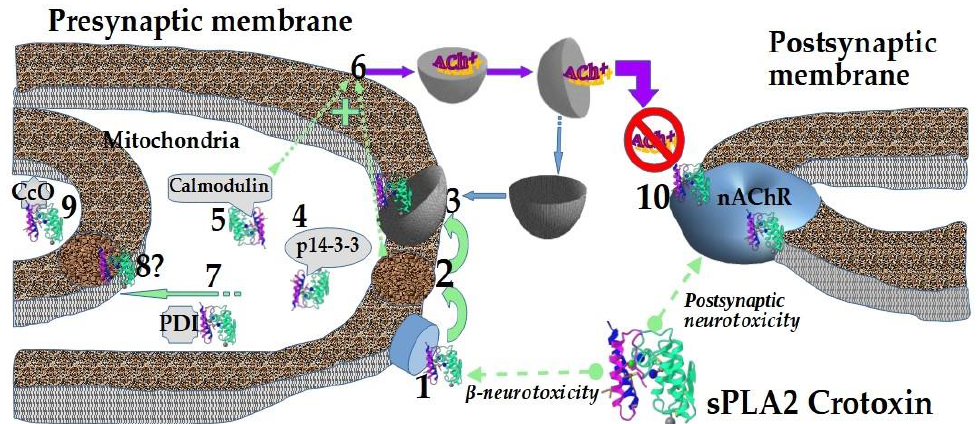
Figure 1. The main processes within neuro-muscular junction known to be affected by snake venom sPLA2 crotoxin: 1—binding to a specific site at presynaptic membrane (presumably to N-type sPLA2 receptor); 2—a general membrane-destabilizing effect and phospholipolysis; 3—translocation across the membrane using the synaptic vesicle recycling machinery; 4—binding to proteins 14-3-3 for localization inside the nerve ending; 5—stabilization by calmodulin with increasing the enzymatic activity; 6—enhancement of exocytosis of acetylcholine (Ach) by products of phospholipolysis; 7—retrograde trafficking provided by protein disulfide isomerase (PDI); 8—putative crossing the outer mitochondrial membrane; 9—binding to subunit II of mitochondrial cytochrome c oxidase (CcO); 10—binding to and block of a nicotinic acetylcholine receptor (nAChR) at postsynaptic membrane. Crotoxin structure is from PDB bank (ID